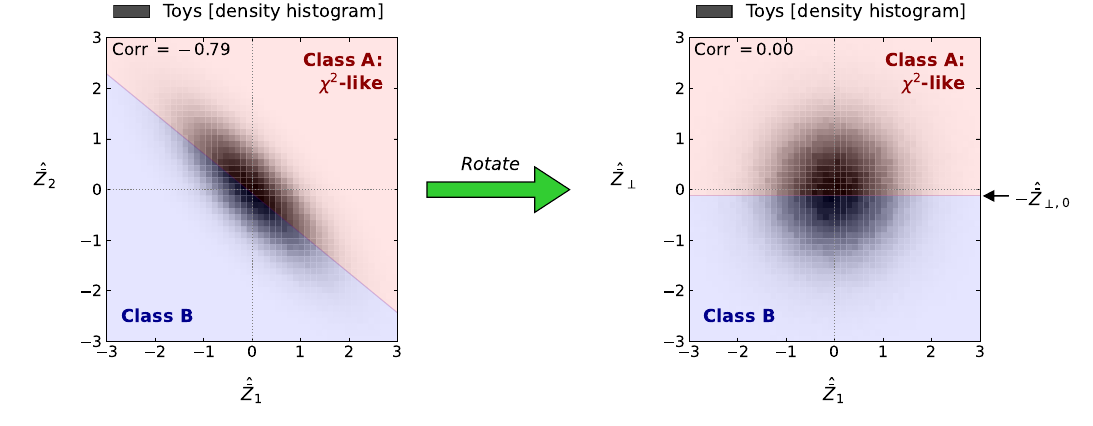
ˆ ¯ Z ˆ ¯ Z ) - and ( ˆ ¯ Z , 1 2